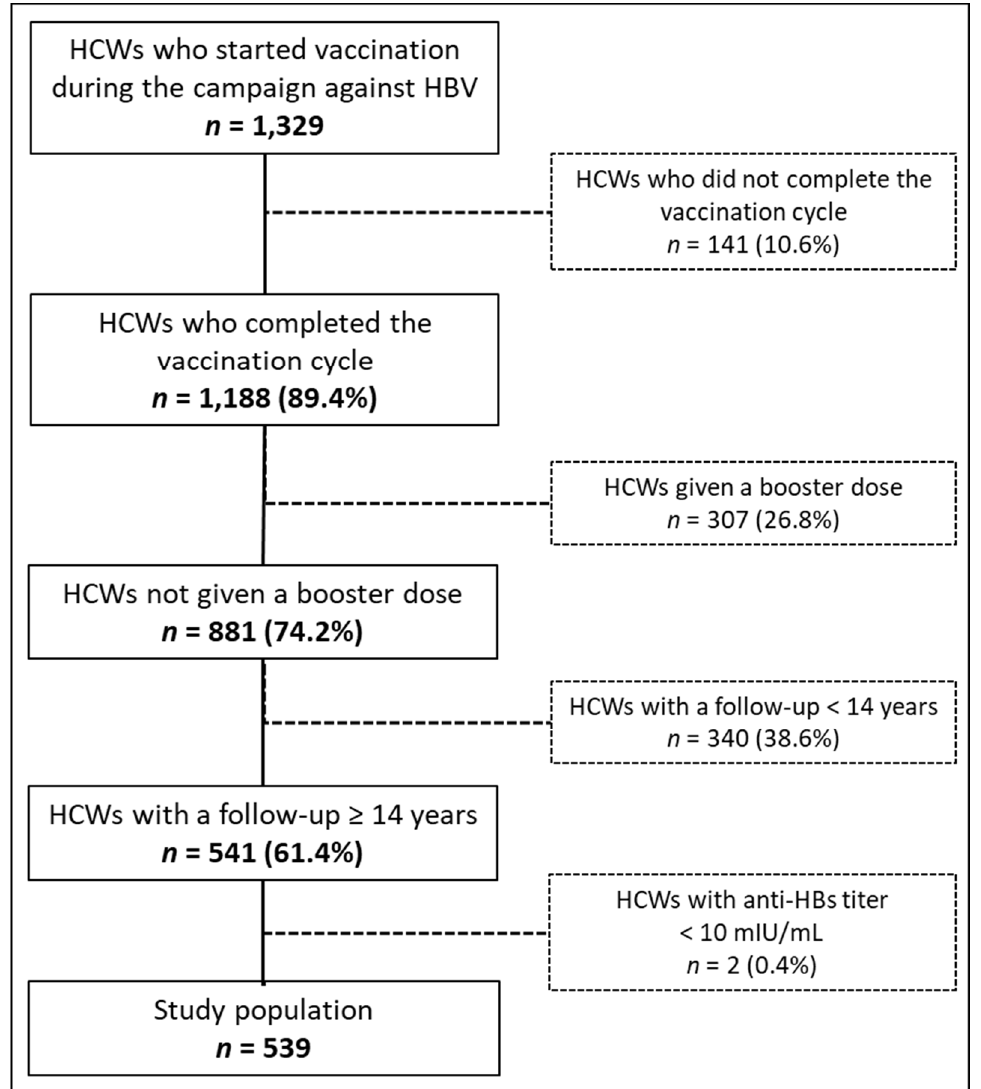
Figure 1. Flow diagram of the study group enrolment process. Table 1. Antibody loss at follow-up in responders to primary immunization.